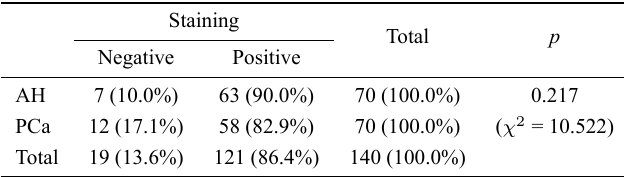
Table 2. Frequency distributions of patients according to PCDH8 staining